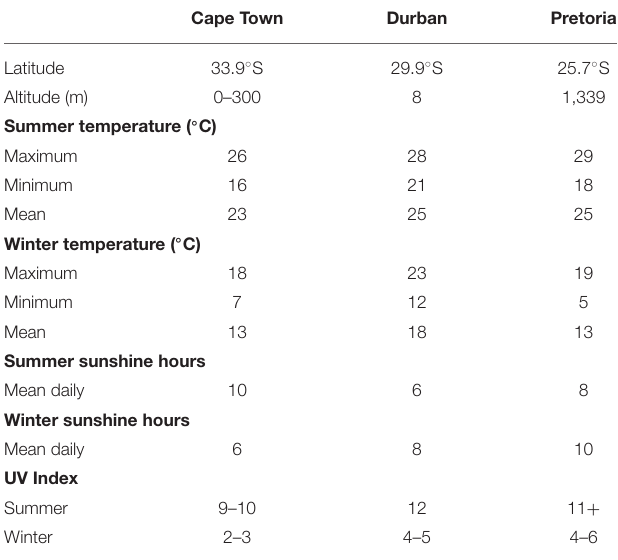
TABLE 1 | Maximum, minimum and mean UV Index, sunshine hours and ambient temperature in summer and winter in Cape Town, Durban, and Pretoria (weather-and-climate.com;